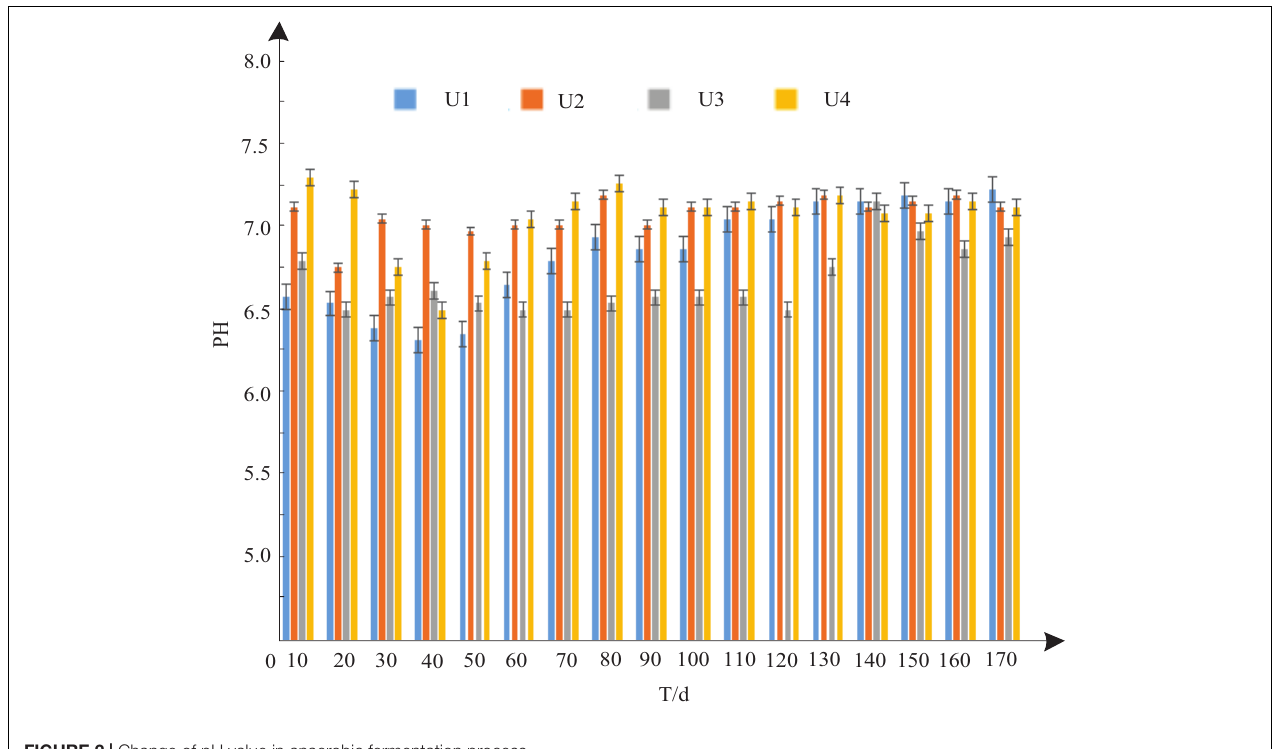
FIGURE 2 | Change of pH value in anaerobic fermentation